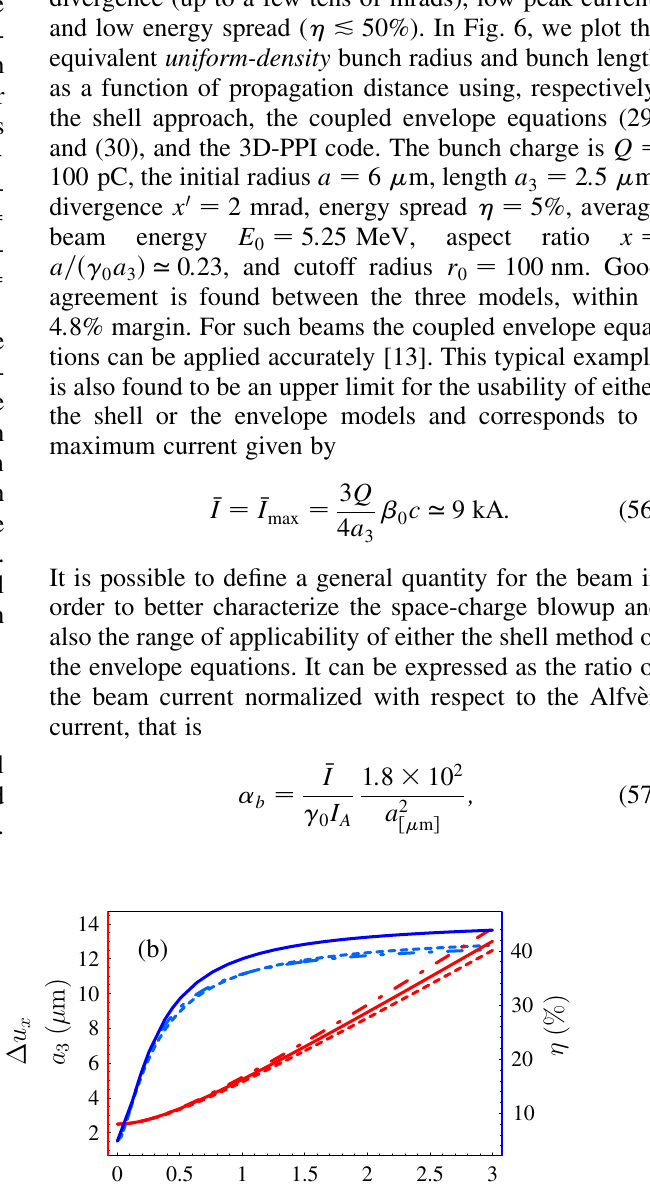
(cid:1) 2 : 5 (cid:4) m , energy spread (cid:5) (cid:1) 4 : 8% , diver- 3 ’ 266 nm , and cutoff radius r (cid:1) 100 nm . Evolution of (a) p 0 0 (cid:1) (cid:1)(cid:1)(cid:1) 5 (cid:10) , (b) longitudinal half-length a and energy spread (cid:5) (cid:1) x z 3